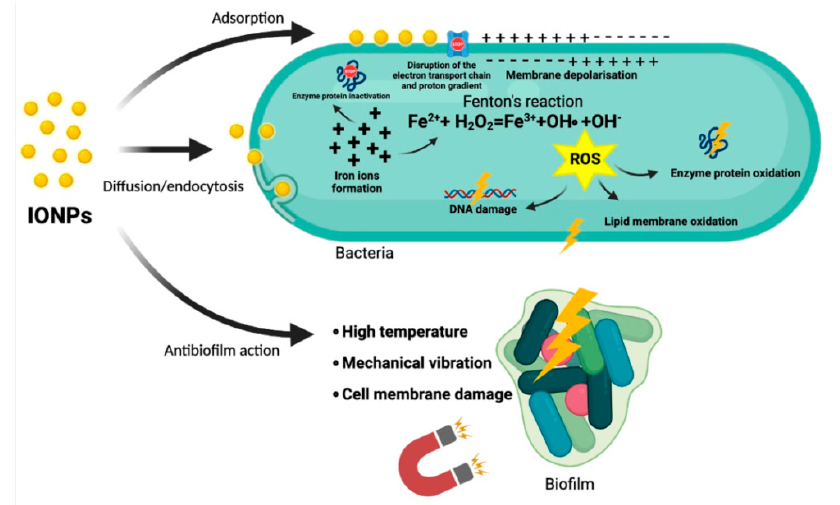
Figure 1. The mechanisms of IONP antibacterial activity.